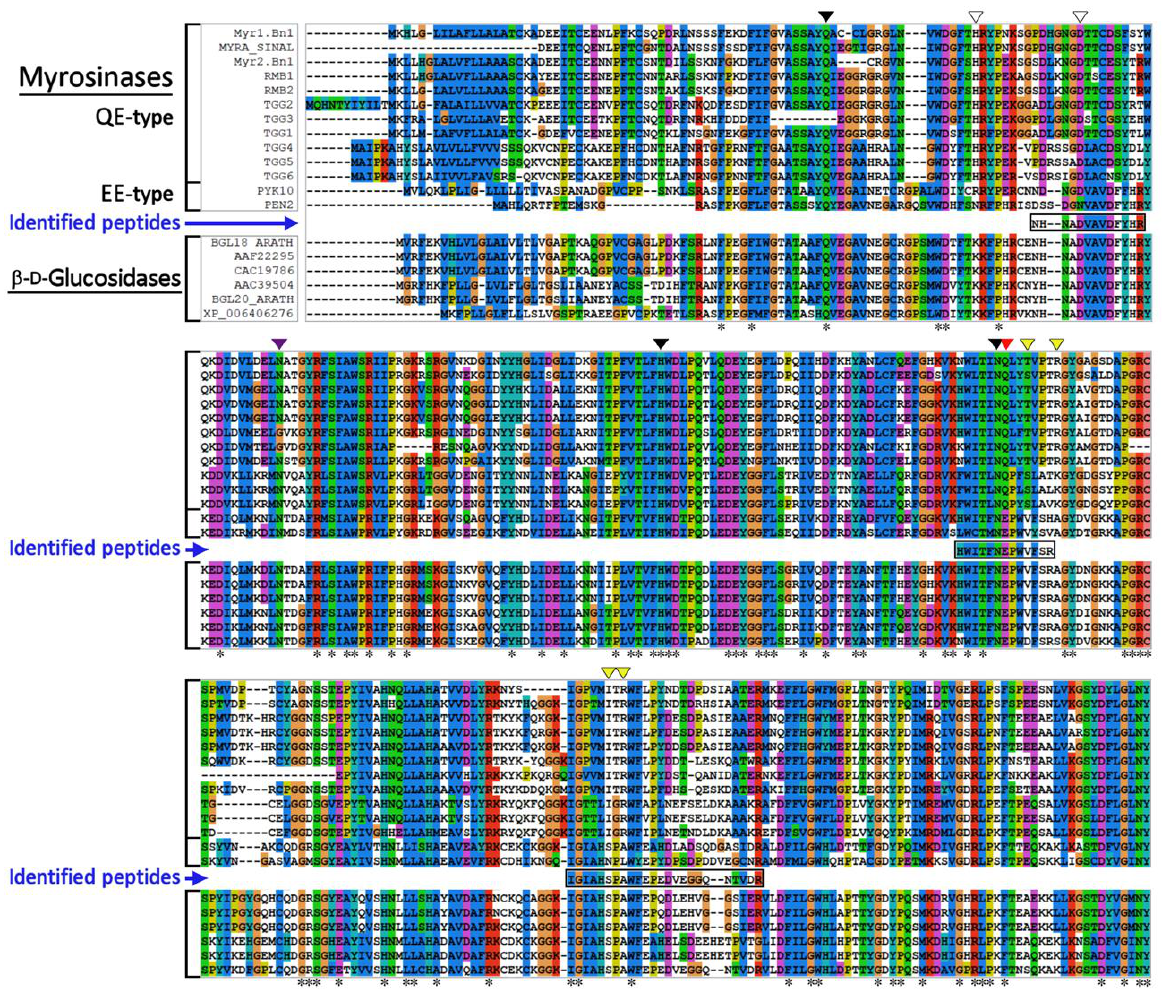
Figure 4. Alignment of myrosinase and β -D-glucosidase sequences with the peptide sequences found in the purified myrosinase from L. sativum seeds. The following sequences from the NCBI database (http://www.ncbi.nlm.nih.gov/)(accessed on 3 january 2022) were used for alignment (accession nos. in parentheses): Myr1.Bn1 (CAA79989) B. napus , MYRA_SINAL (P29736) S. alba , Myr2.Bn1 (CAA79990) B. napus , RMB1 (BAB17226) R. sativus , RMB2 (BAB17227) R. sativus , TGG1 (CAA55786) A. thaliana , TGG2 (AAM44928) A. thaliana , TGG3 (NP_680406) A. thaliana , TGG4 (ACO95139) A. thaliana , TGG5 (ACO95140) A. thaliana , TGG6 (ACO95141) A. thaliana , PYK10 (Q9SR37) A. thaliana , PEN2 (O64883) A. thaliana , BGL18_ARATH (Q9SE50) A. thaliana , AAF22295 A. thaliana , CAC19786 A thaliana , AAC39504 A. thaliana and BGL20_ARATH (Q84WV2) A. thaliana . Blue arrows indicate peptide sequences from the isolated myrosinase identified by MALDI-Tof/Tof technology. The amino acid residues in each column are colored according to the consensus character assigned to that column. More details about the ClustalX color scheme are given in the documentation in: http://www.clustal.org/download/clustalx_help.html (Accessed on 14 January 2022) or http://www.jalview.org/help/html/colourSchemes/clustal.html (Accessed on 14 January 2022). Explanation of symbols used in figure: residues involved in binding of the D-glucopyranoside (black triangle) and aglycone moiety (yellow tiangle); catalytic nucleophile residue (red traingle); residues chelating Zn 2+ ions (white triangle); residues involved in glycosylation sites (purple triangle) [31]; The conserved amino acids in the respective positions on the peptide chain are marked with (*). Table 2. Kinetic parameters of the L. sativum myrosinase for hydrolysis of the different glucosinolate substrates assayed with the GOP method.